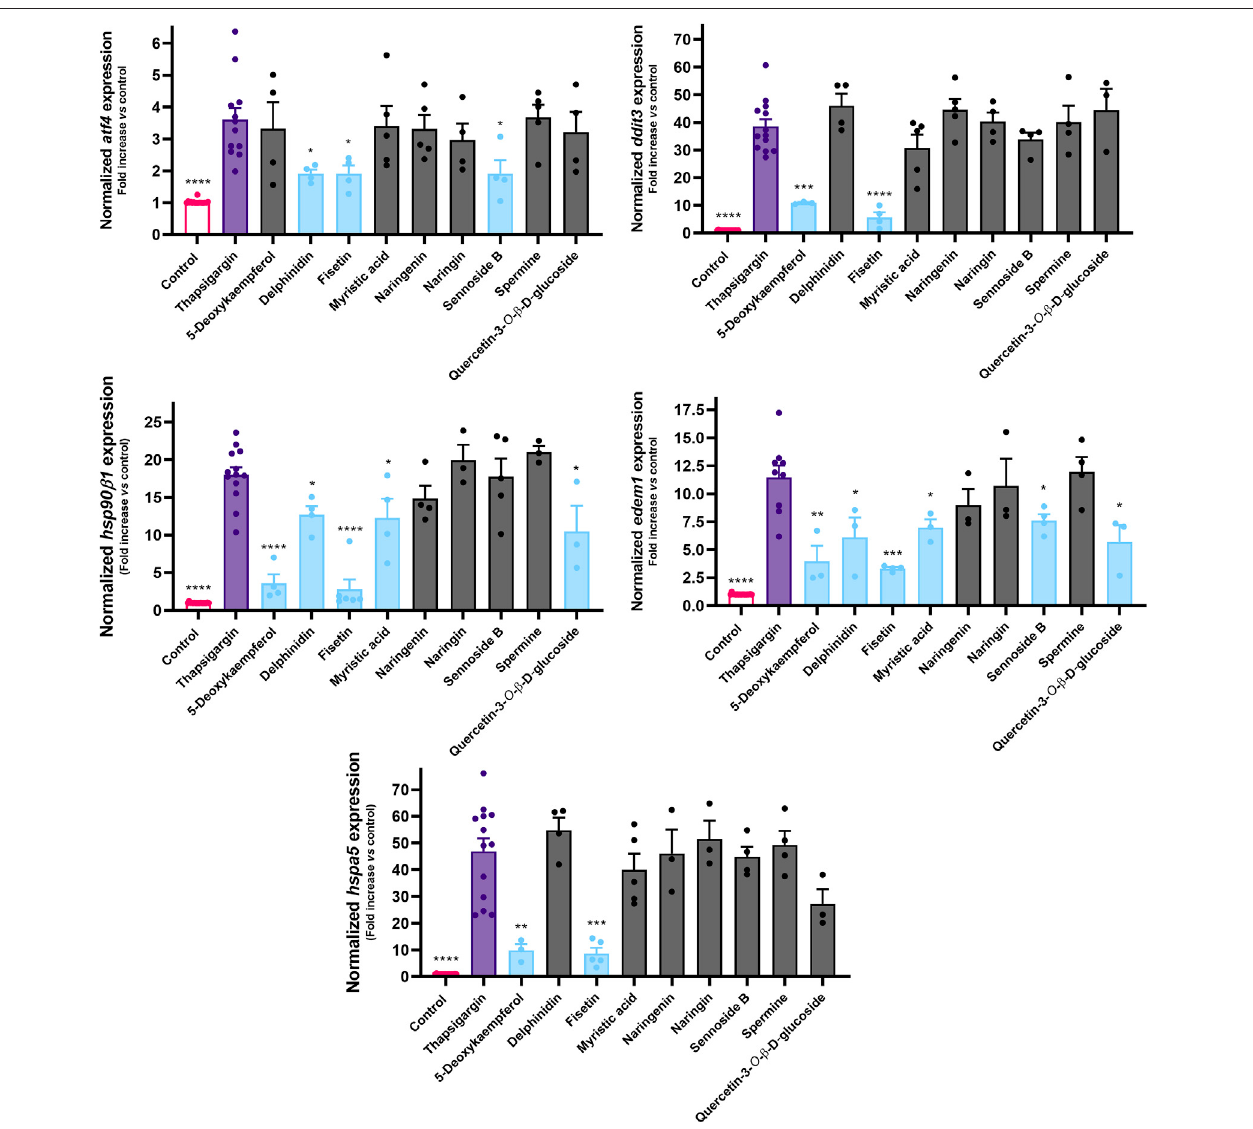
FIGURE 4 | Effect of 5-deoxykaempferol, delphinidin, fi setin, myristic acid, naringenin, naringin, sennoside B, spermine and quercetin-3- O - β -D-glucoside on Tg- induced UPR signaling, as determined by RT-qPCR. Results correspond to the mean ± standard error of the mean of, at least, four independent experiments, each performed in duplicate. GAPDH was used as a reference gene for normalization of expression.